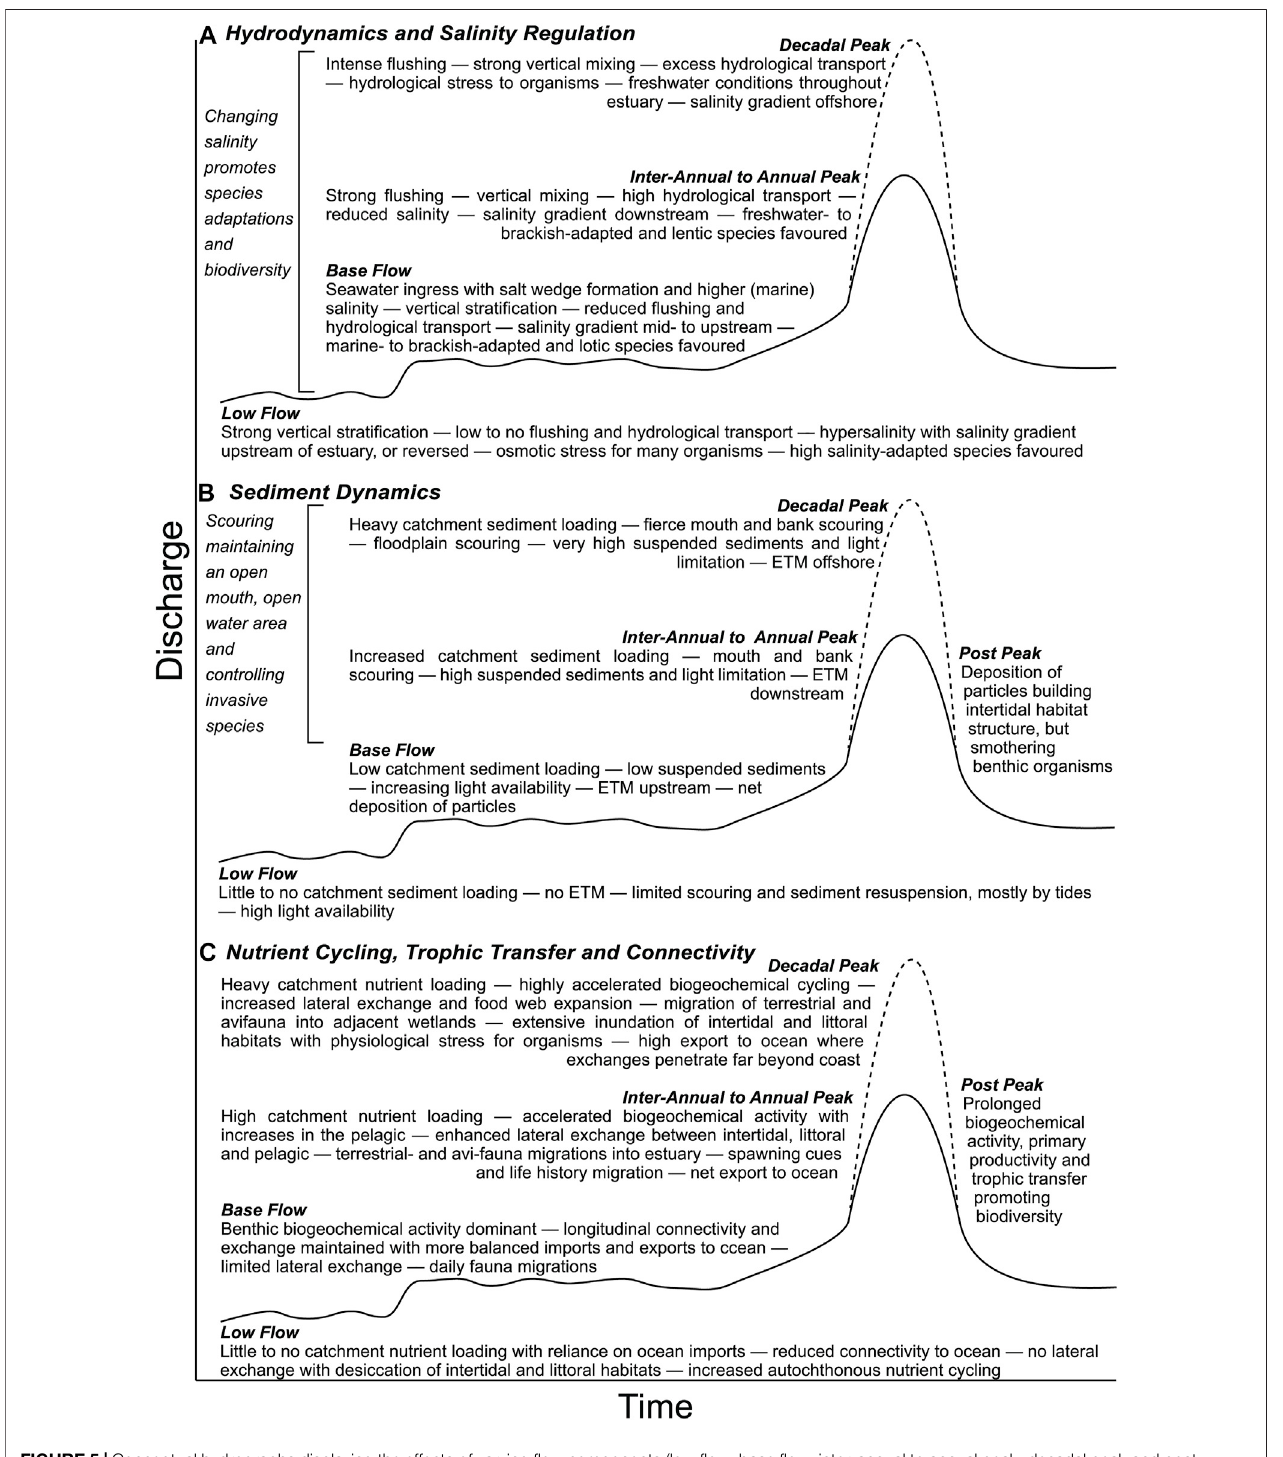
FIGURE 5 | Conceptual hydrographs displaying the effects of varying fl ow components (low fl ow, base fl ow, inter-annual to annual peak, decadal peak and post peak) of the freshwater fl ow regime on the functioning of the key ecosystem processes: hydrodynamics and salinity regulation (A) , sediment dynamics (B) , and nutrient cycling, trophic transfer and connectivity (C)